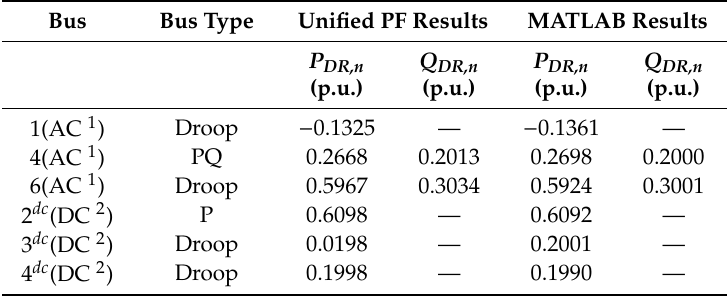
Table 7. Test results of the output power of the distributed energy resource (DER) in the 12-bus IHMG system.